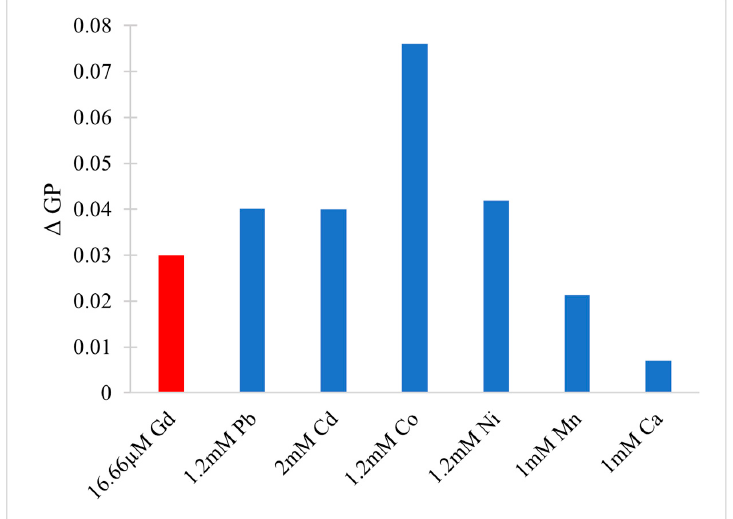
Figure 11. Generalized polarization of BPE liposomes in the presence of various heavy metals. Order of increasing metal concentrations: